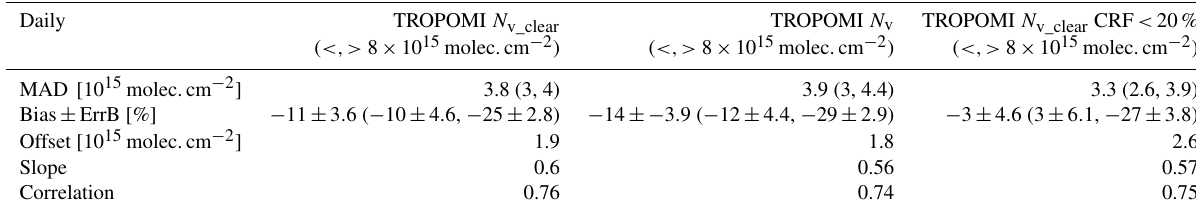
Figure 16. Median monthly bias as a function of the radius taken around the validation sites. Pink areas indicate 40% bias. Table 4. Summary of daily validation results for TROPOMI when considering all collocated pairs when using (baseline) N v_clear (first column), (1) when using N v (second column) or (2) when using a strict cloud filter (third